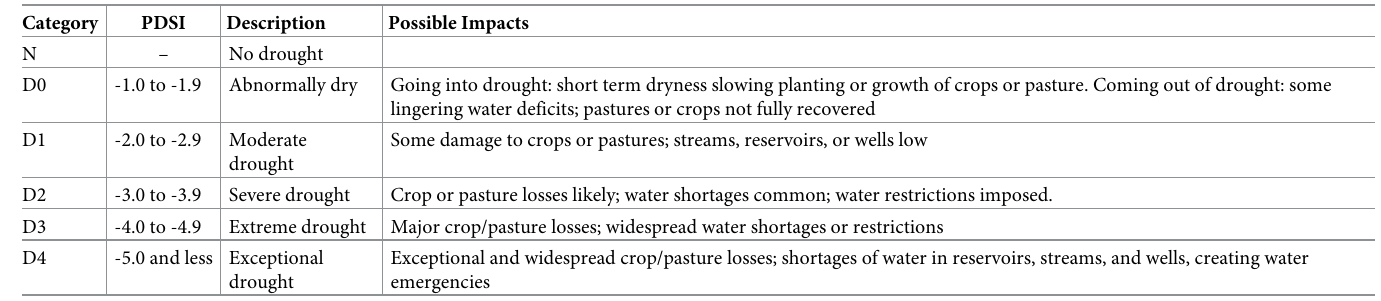
Table 1. Drought categories, palmer drought severity indices (PDSI), descriptions, and possible impacts. Data source: National Drought Mitigation Center. 2016. Accessed November